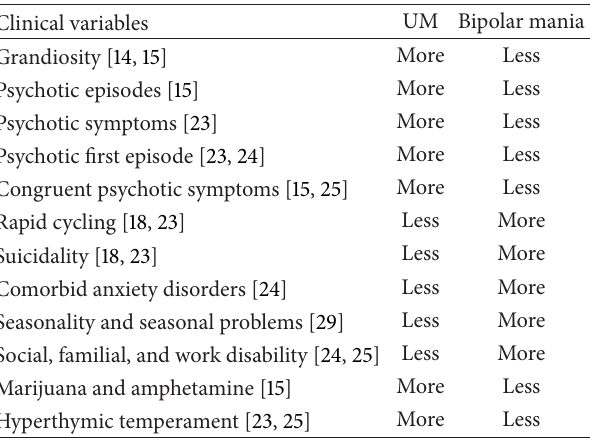
Table 2: Differences in clinical variables between UM and bipolar